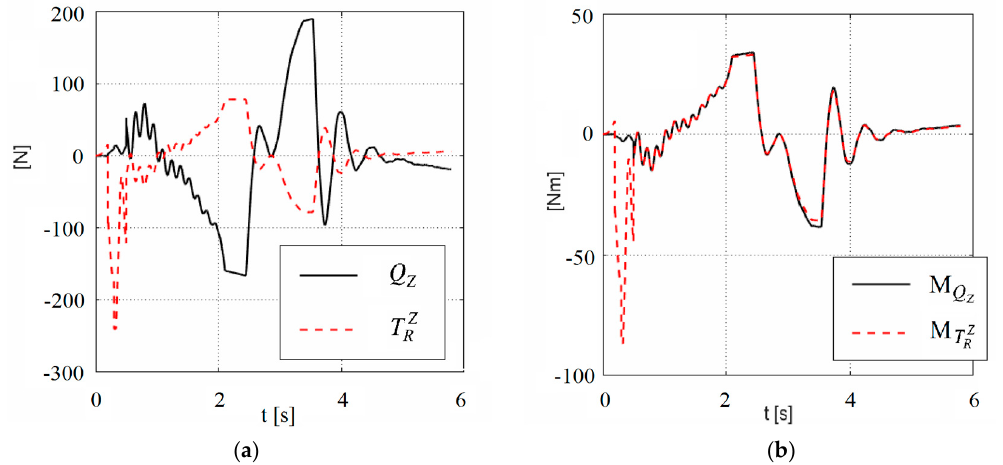
Figure 9. The performed control forces ( a ) and moments ( b ) of the anti-tank guided missile flight in the vertical plane.